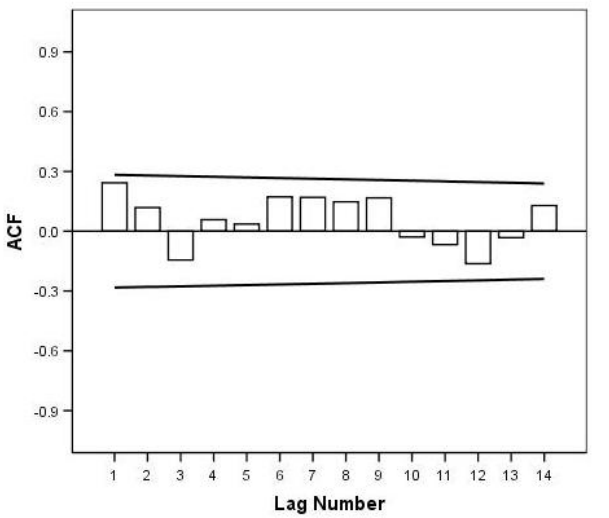
Fig. 2. Autocorrelation function for the cold days (TX10p) time se- Figure 2. Autocorrelation function for the cold days (TX10p) time series of the ries of the observatory of “airport of Barcelona” obtained by taking observatory of “airport of Barcelona” obtained by taking 14-year differences (solid 14-yr differences (solid line refers to the upper and lower limit of line refers to the upper and lower limit of the 95 % significance level given by ± 1.96 ( the 95% significance level given by ± 1.96 ( 1 √ ) where n = 47 for n 1 the period 1960–2006. n ) where n = 47 for the period 1960-2006.